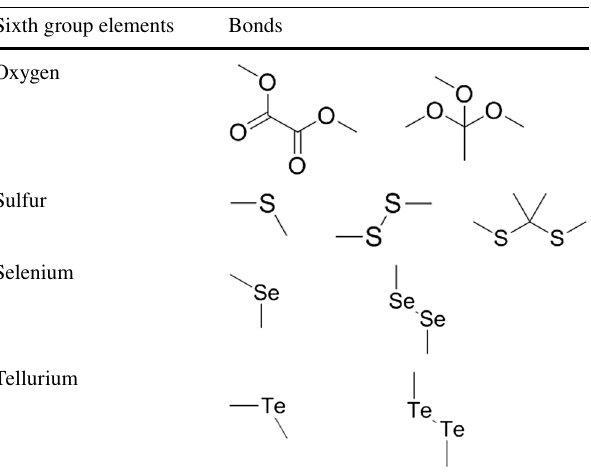
Table 1 H 2 O 2 -responsive bonds based on the sixth main group ele-